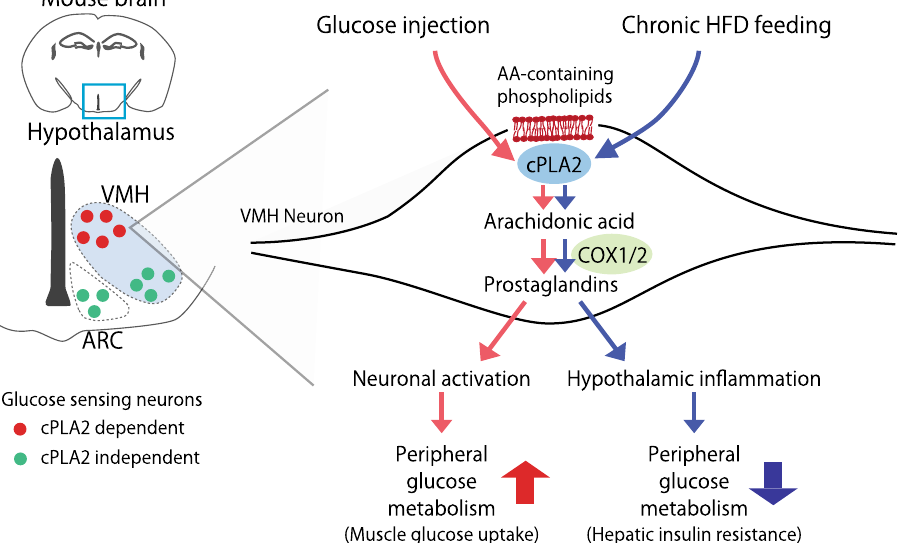
Fig. 7 Distinct roles of prostaglandin in the regulation of peripheral glucose metabolism. In RCD-fed mice, a glucose injection activates cPLA2 in the VMH, which increases the production of prostaglandins from neurons. The increase in prostaglandins is critical for the activation of dmVMH and glucose metabolism in peripheral tissues. Chronic HFD feeding also increases the cPLA2-mediated prostaglandin production from VMH neurons. The chronic effect of prostaglandin enhances hypothalamic in fl ammation and thus impairs peripheral glucose